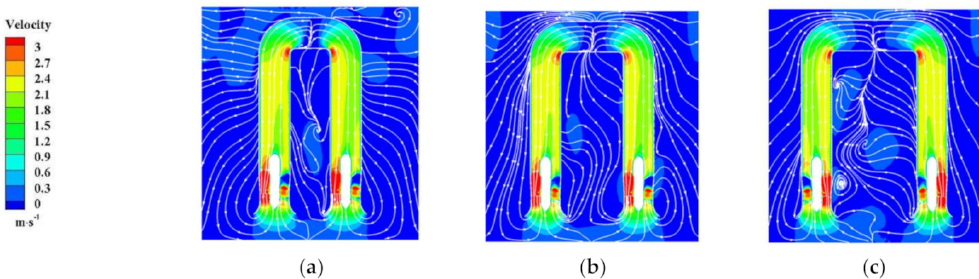
Figure 10. Streamline and velocity distribution nephogram of Section 1-1 under different S values: ( a ) S = 0.6 R ; ( b ) S = 0.8 R ; ( c ) S = 1.0 R.